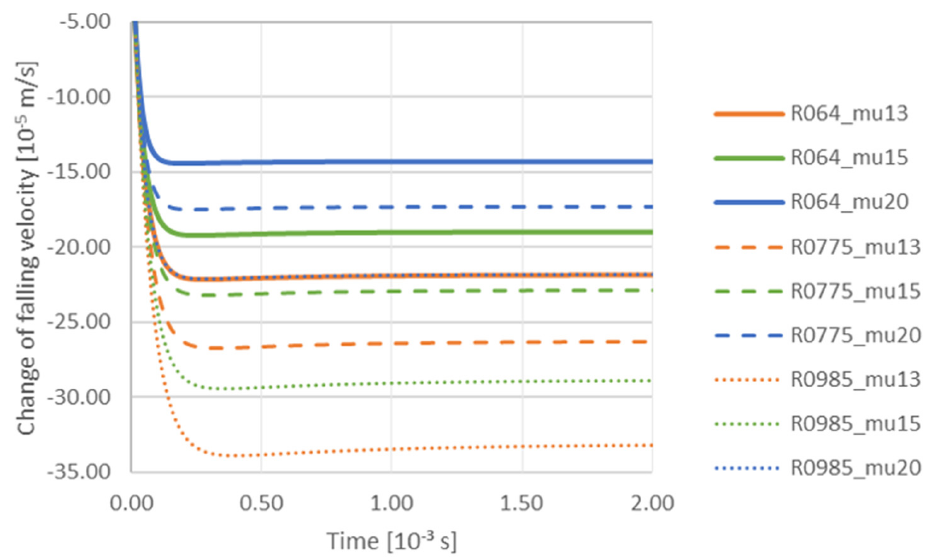
Figure 8. Analysis of influence of TiC particle size and viscosity on the change of falling velocity with time at a constant gradient 0.00001 m/s. Radius of particle: R064—6.40 × 10 − 8 m; R0775—7.75 × 10 − 8 m; R0985—9.85 × 10 − 8 m. Viscosity: mu13—0.0013 Pa · s; mu15—0.0015 Pa · s; mu20—0.0020 Pa · s.